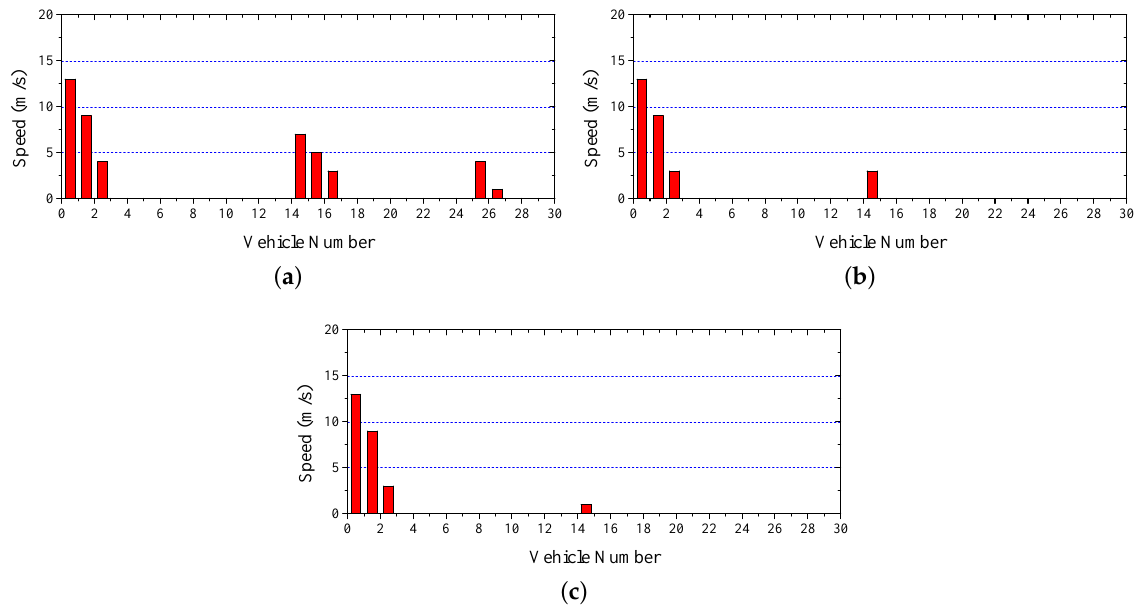
Figure 9. Safety Warning: Speed difference between two consecutive vehicles. ( a ) IEEE 802.11p; ( b ) VeMAC; ( c ) CTMAC.